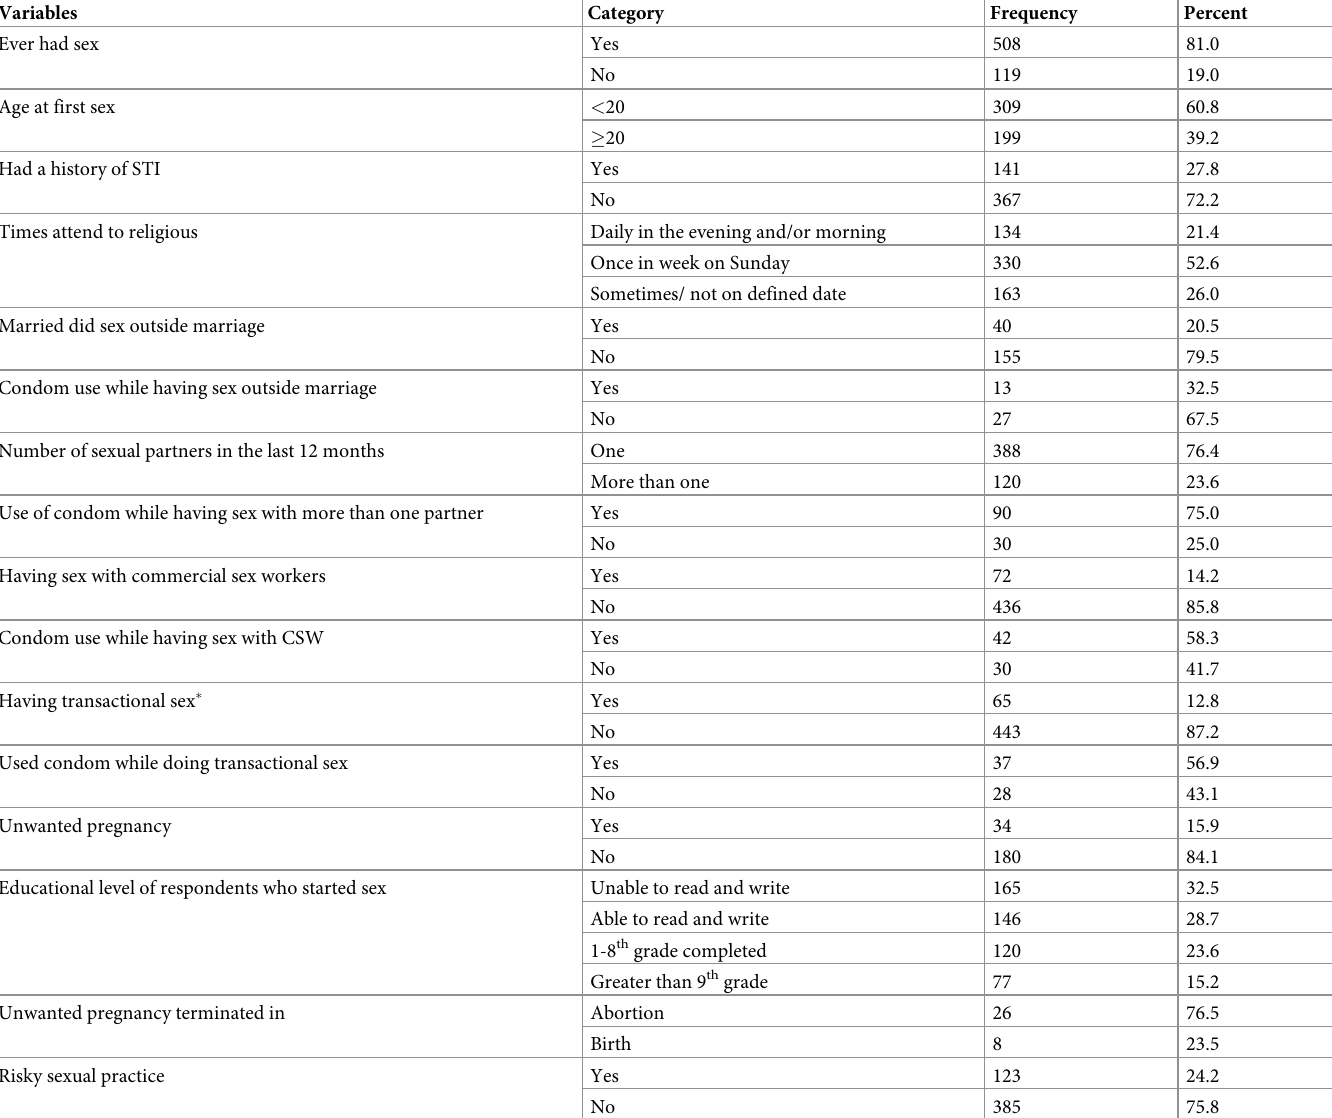
Table 2. Sexual practice and pregnancy related variables among study participants of big construction daily